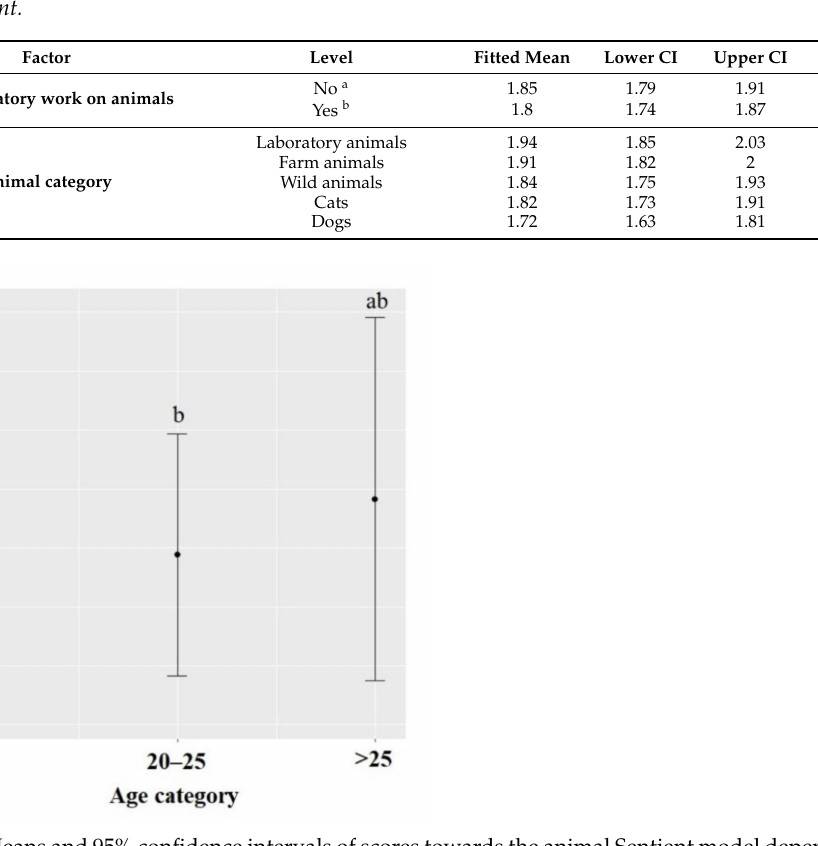
Figure 2. Means and 95% confidence intervals of scores towards the animal Sentient model depending on the students’ age. Means and 95% confidence intervals have been back-transformed from a log scale. Different letters represent significant differences (Wald chi-square with Bonferroni correction).